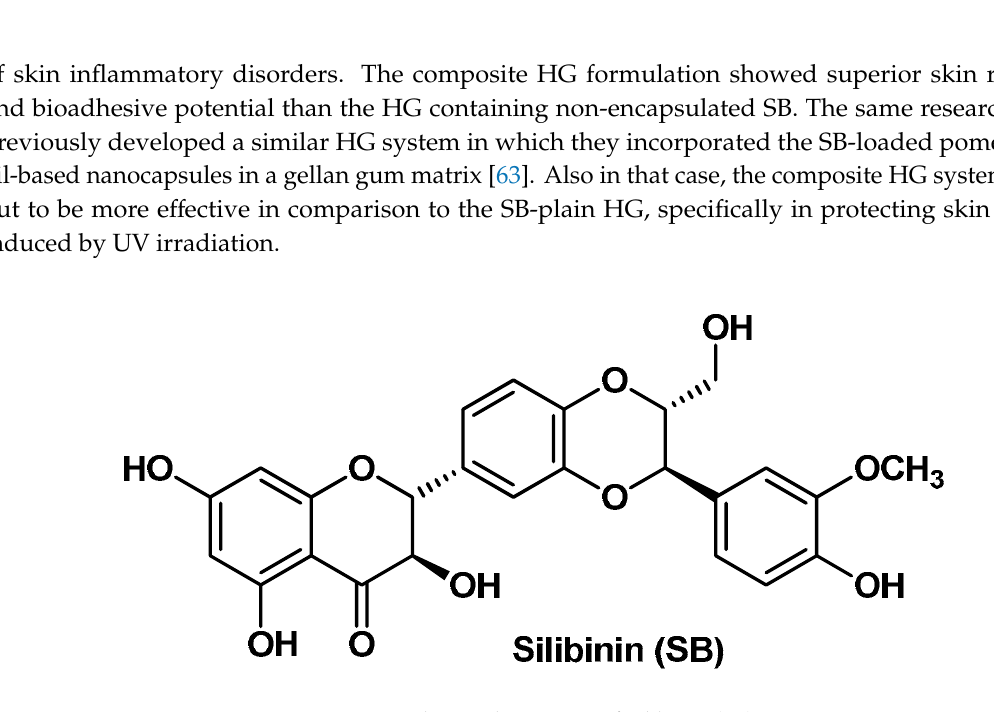
Figure 4. Chemical structure of Silibinin (SB).